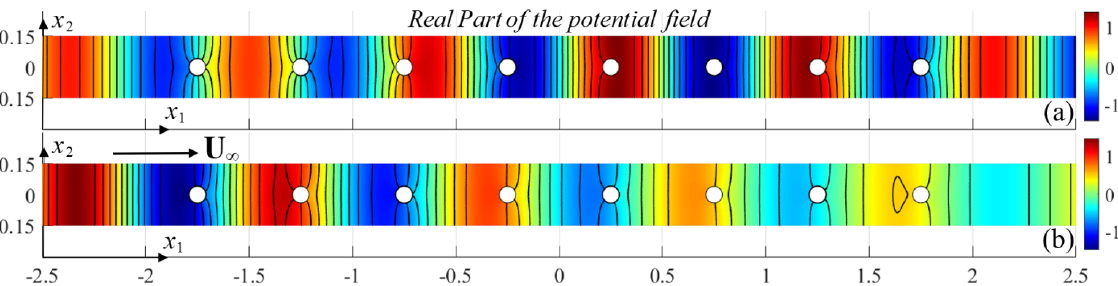
Figure 15. Modulus of the wave field in the 10 m long and 0.3 m wide waveguide of water depth h = 0.305 m, resulting from the interaction of an incident field of frequency f = 1.3Hz, with an array of eight cylinders ( a ) in the absence of currents and ( b ) in the presence of a steady following current corresponding to volumetric flow rate Q = 70.5cm 3 /s.